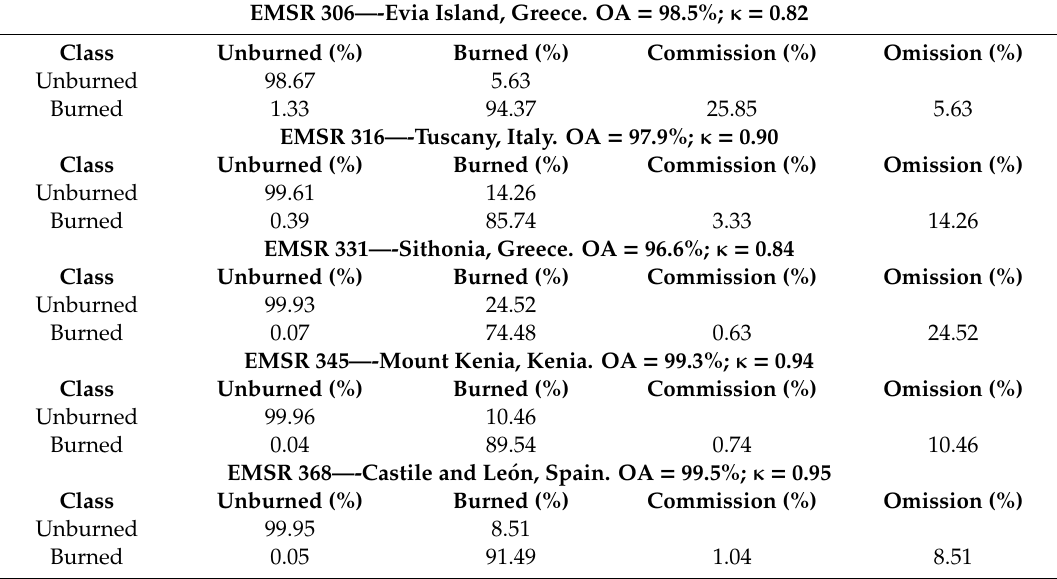
Table 2. Results of the comparison between AUTOBAM-derived and CEMS-derived maps of burned areas for the case studies listed in Section